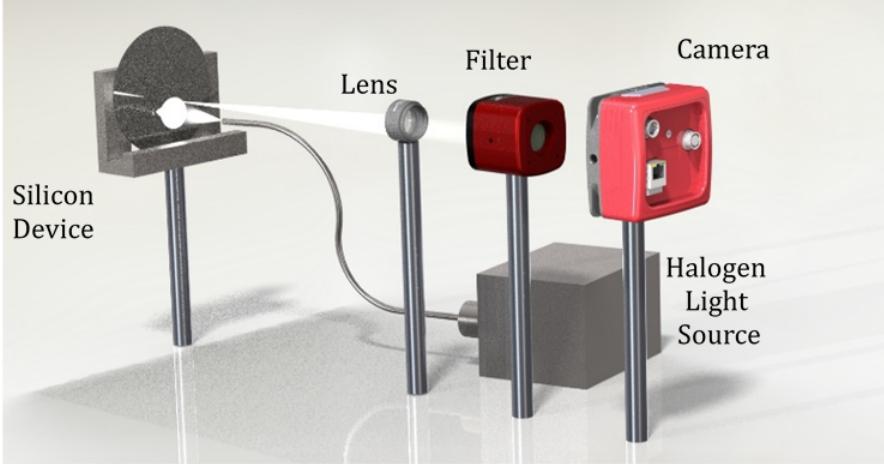
Figure 3. Schematic diagram of principal system